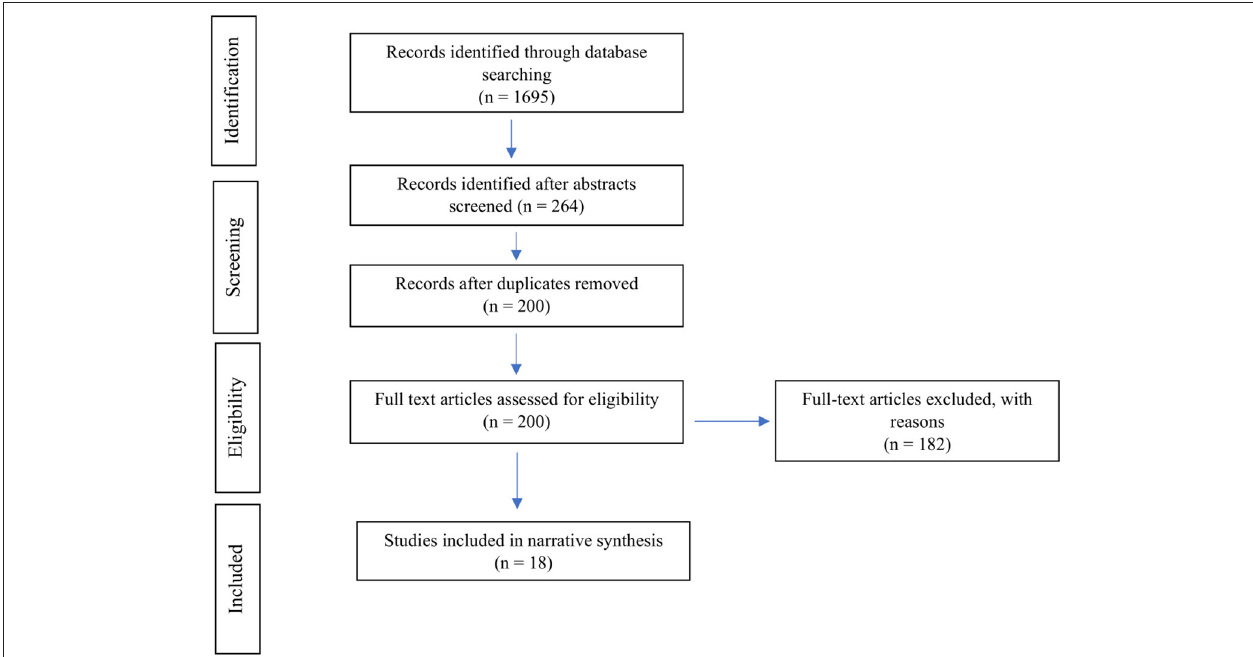
FIGURE 1 | PRISMA flow diagram for the present